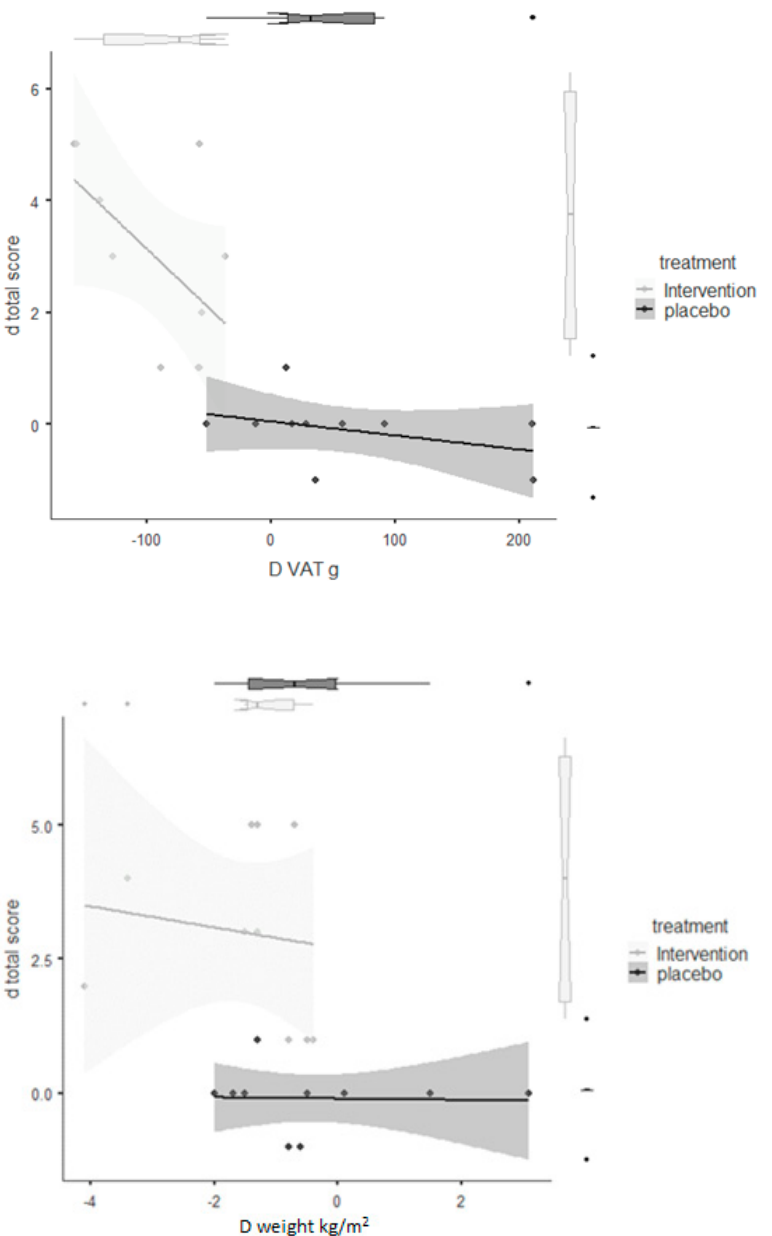
Figure 3. Delta change correlation divided by groups (intervention and placebo) between VAT and total score of five-point evaluation scale. None of the intervention or control group refused the supplement or placebo and no side effects were reported during the